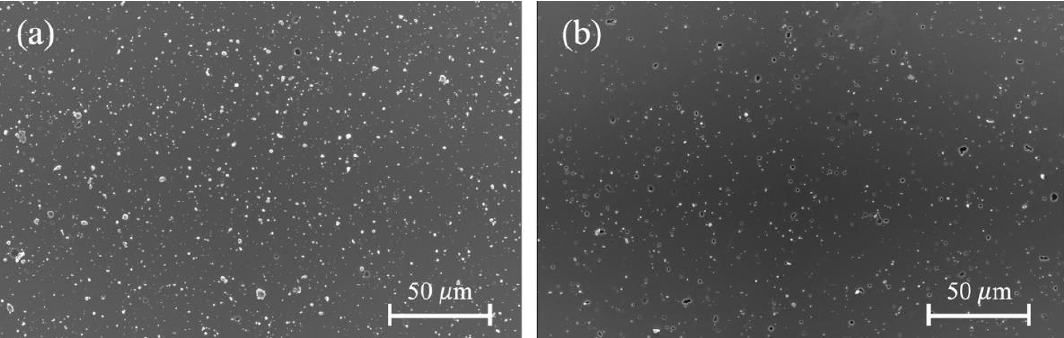
Figure 7. SEM plane-view images of deposited films obtained with different cross-section areas: ( a ) 227 cm 2 and ( b ) 64 cm 2 .